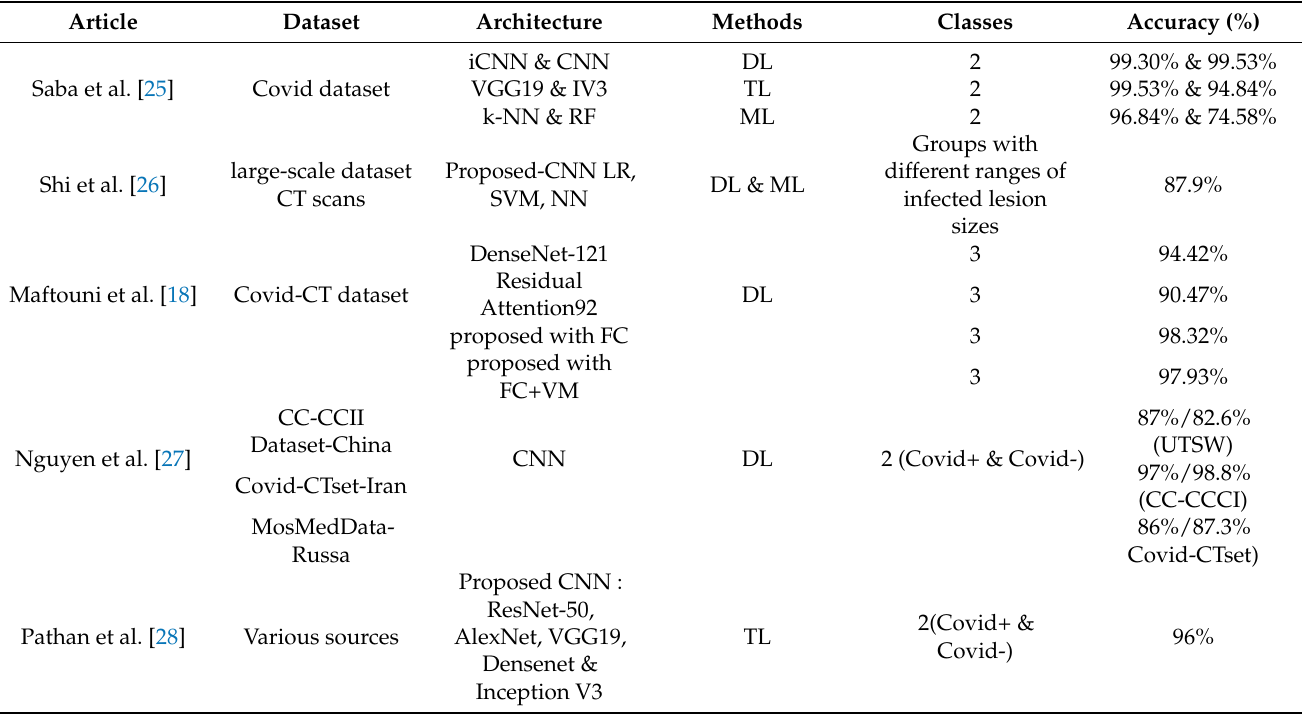
Table 2. Datasets, architectures, methods, and accuracy of CT scan-based approaches (CoP and NCoP stand for COVID-19 Pneumonia and Non-COVID 19 Pneumonia respectively).